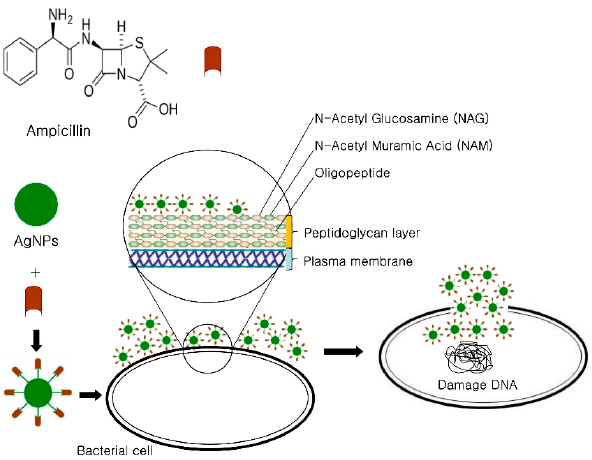
Figure 3. Proposed antibacterial mechanisms of ampicillin plus AgNPs. AgNPs-ampicillin in combination hinders the formation of crosslinks in the peptidoglycan layer, which results in cell lysis. AgNPs-ampicillin complex inhibits DNA